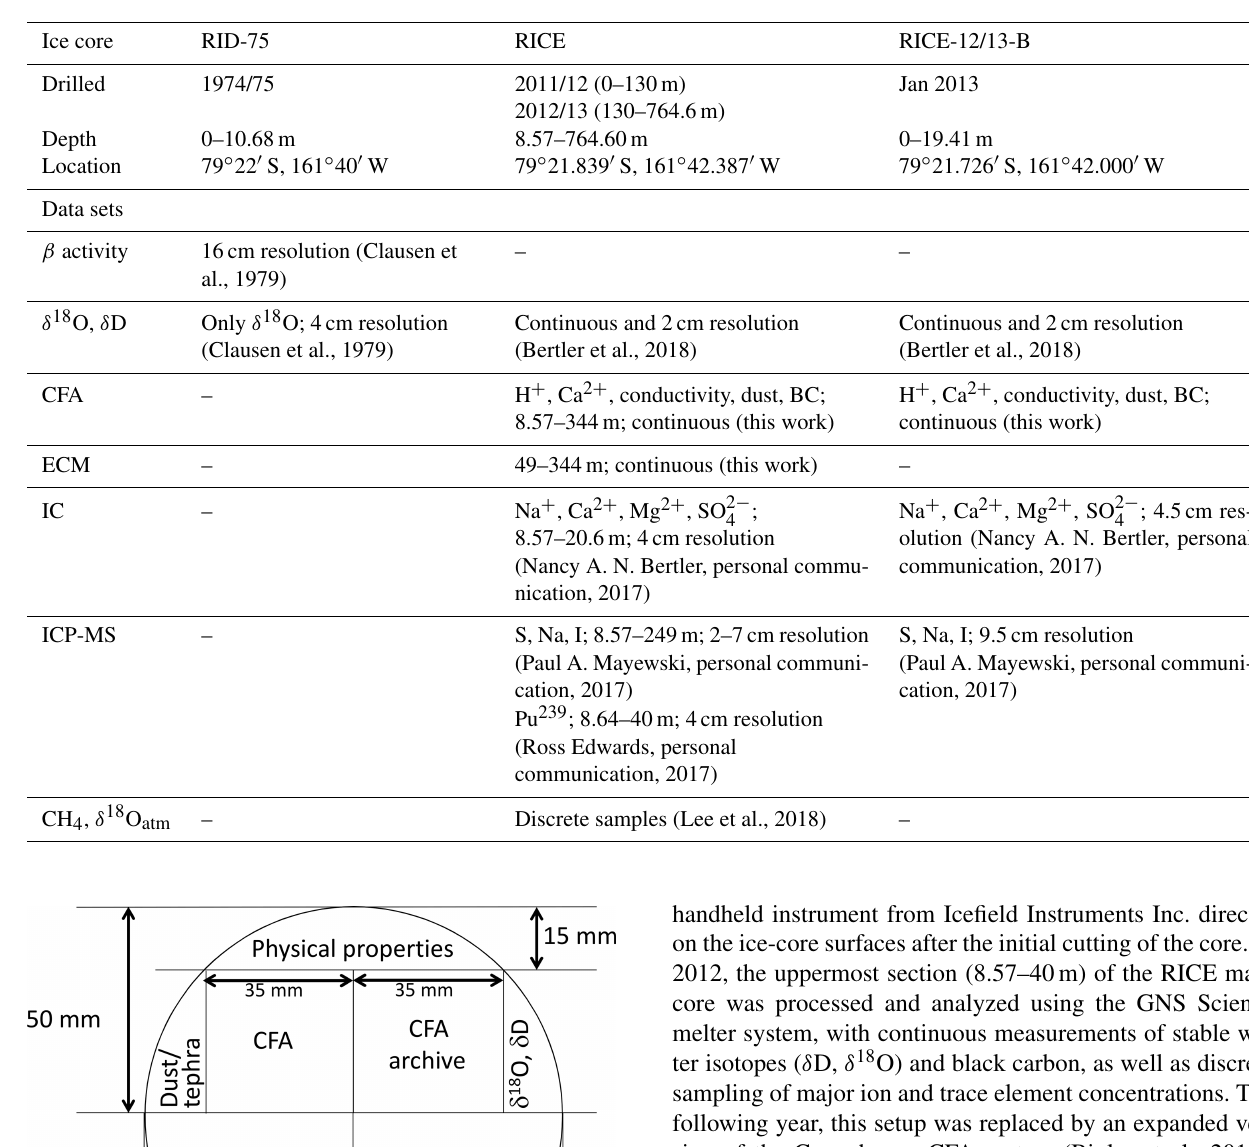
Table 1. The Roosevelt Island ice- and firn-core records used in this study.